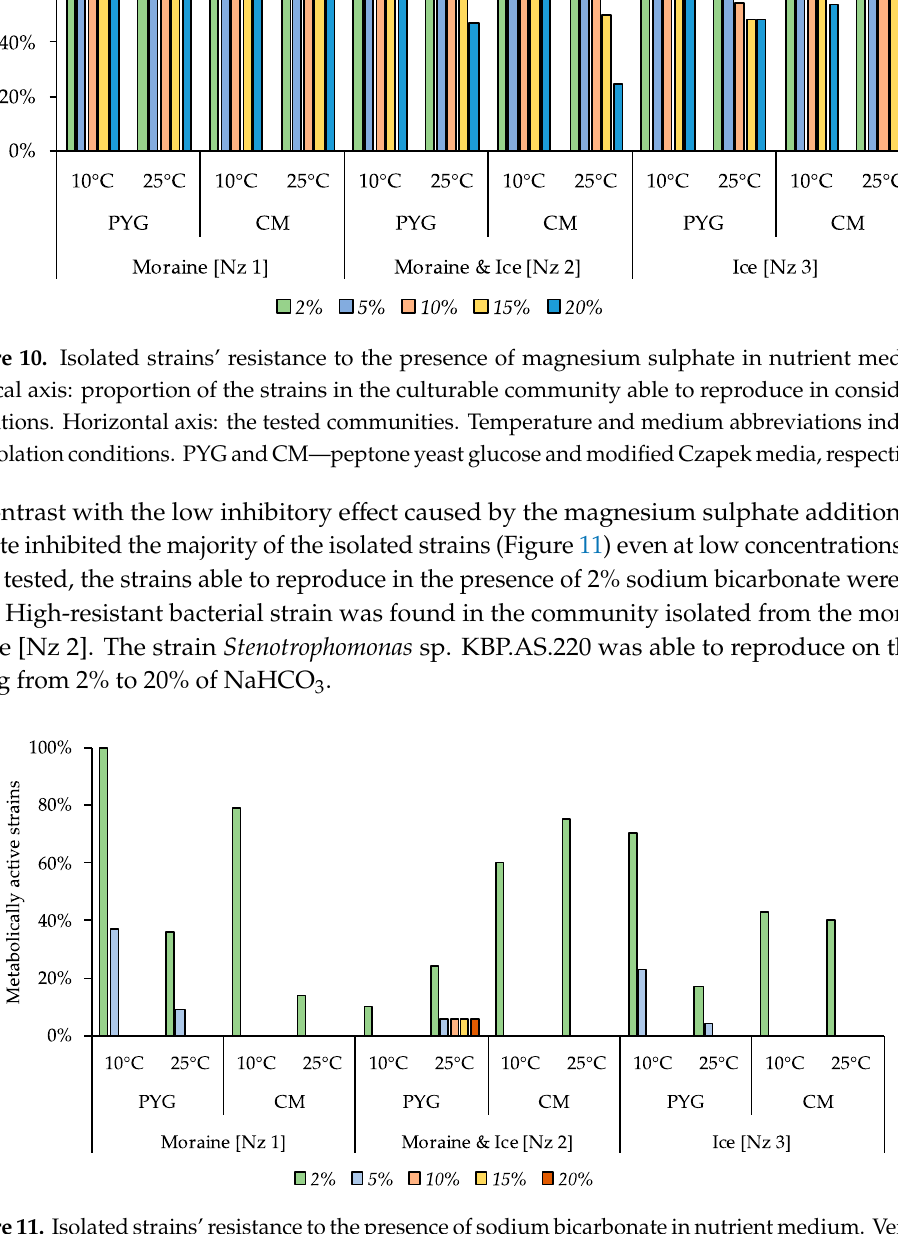
Figure 9. Isolated strains’ resistance to the presence of potassium chloride in nutrient medium. Vertical axis: proportion of the strains in the culturable community able to reproduce in the considered conditions. Horizontal axis: the tested communities. Temperature and medium abbreviations indicate the isolation conditions. PYG and CM—peptone yeast glucose and modified Czapek media, respectively.